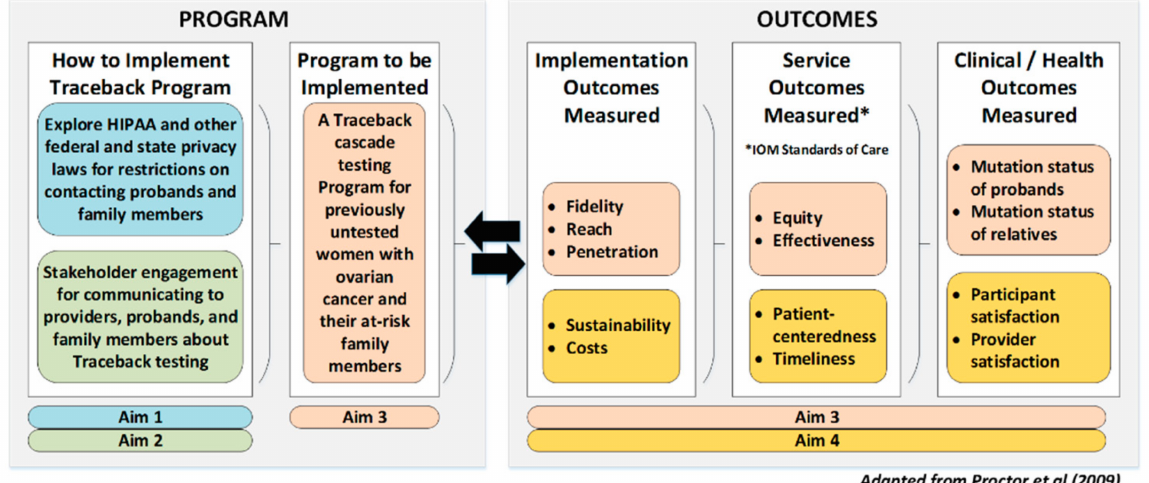
Figure 1. FACTS study conceptual model: adapted from Proctor et al.’s (2009) conceptual model of implementation